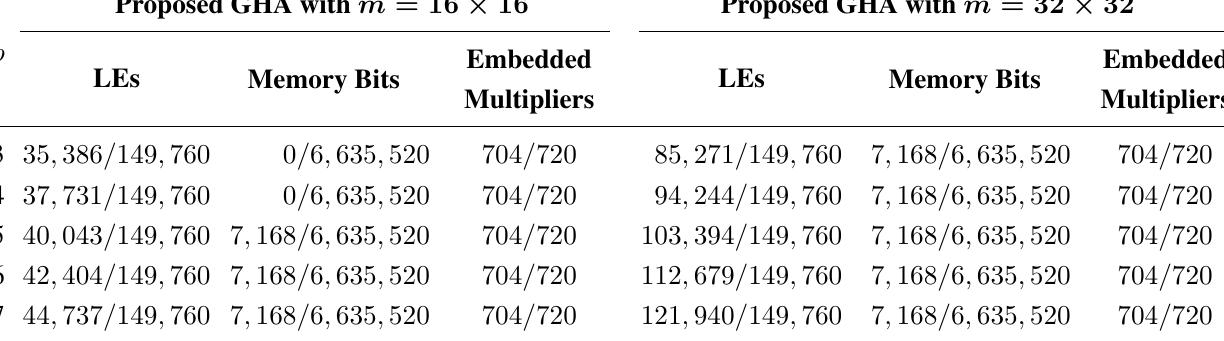
Table 2. Hardware resource consumption of the proposed GHA architecture for vector dimensions m = 16 × 16 and m = 32 × 32 .